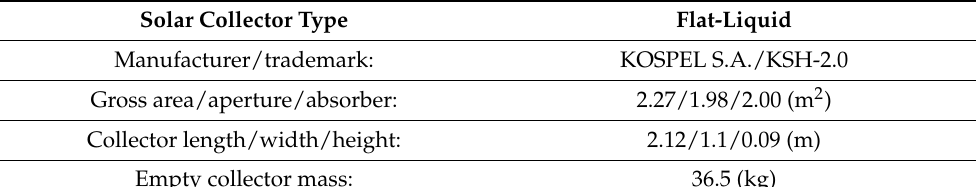
Table 5. Technical specification of the KSH-2.0 collector.